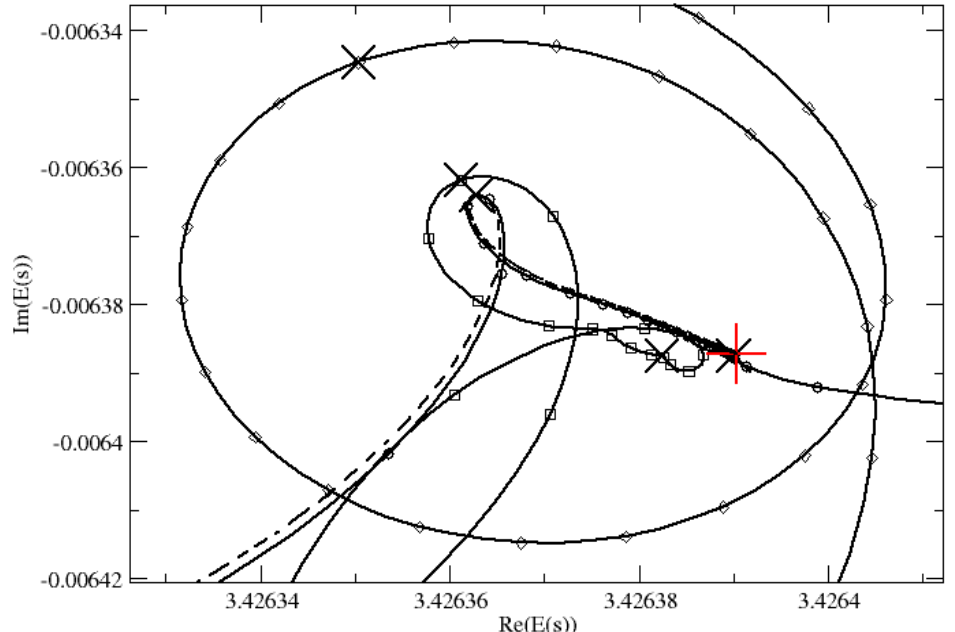
Figure 2. Trajectories (problem I, z 0 = 0) for different values of ζ = Re ( s ) , i.e., — ζ = 0.01, (cid:3) — ζ = 0.12, ♦ — ζ = 0.36. The dashed line corresponds to ζ = 0. Signs + and x indicate the position of the resonance and optimal point, respectively. Data are presented in a.u.